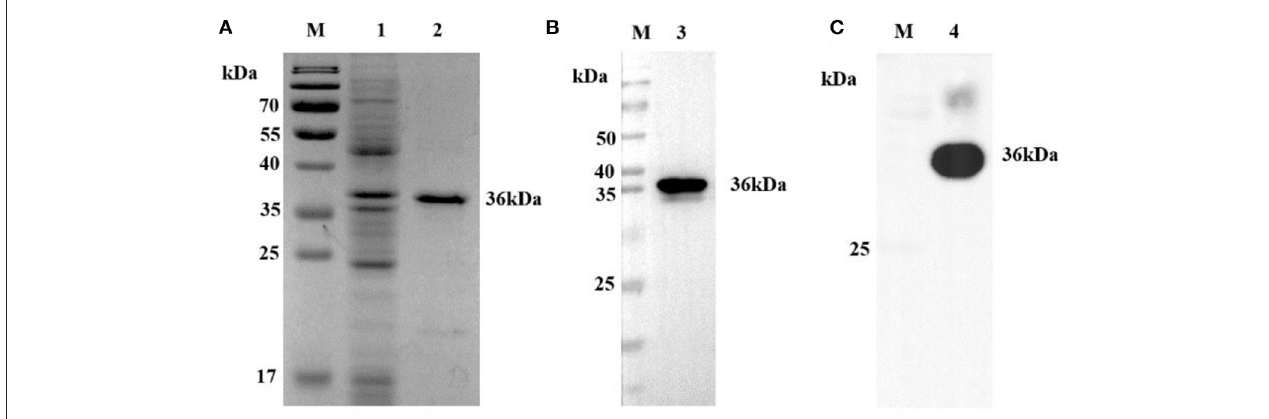
FIGURE 1 | Analysis of p30 protein. (A) SDS-PAGE analysis of recombinant p30 protein. The recombinant protein can be seen at 36 kD (Black). (B) Western blot analysis of recombinant p30 protein with anti-His tag antibody. The recombinant protein can be seen at 36 kD (Black). It can be seen that the recombinant protein can react specifically with anti-His mAb. (C) Western blot analysis of recombinant p30 protein with ASFV positive serum. The recombinant protein can be seen at 36 kD (Black). It can be seen that the recombinant protein can react specifically with ASFV positive serum; M: protein Marker; 1: Negative control; 2, 3, 4: p30